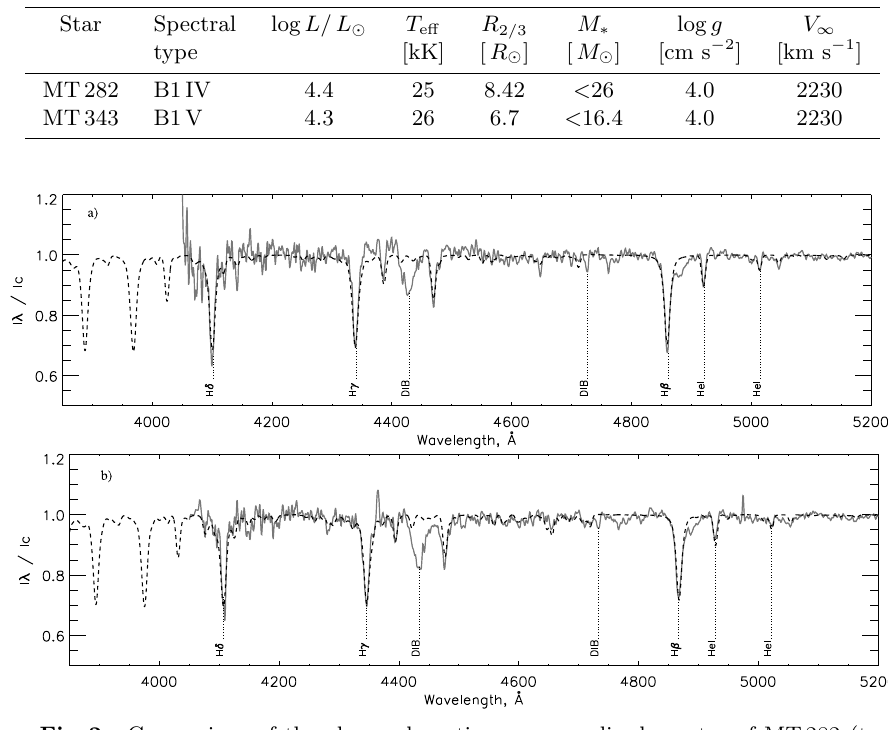
Fig. 2. Comparison of the observed continuum-normalized spectra of MT 282 (top) and MT 343 (bottom) with the cmfgen -model (the dashed